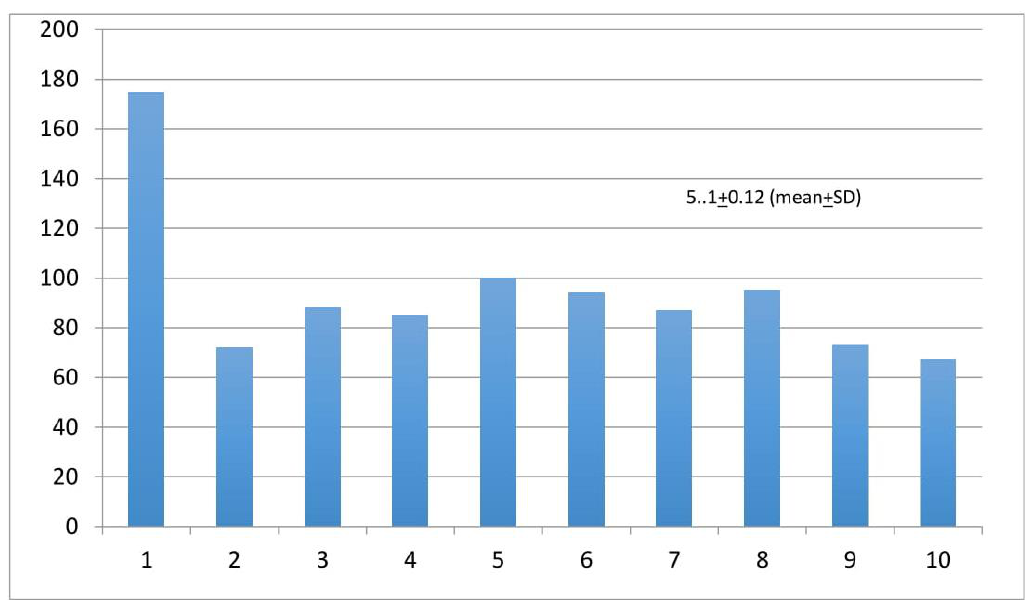
Figure 5. Support from local public health authorities in regards to the protection of physical integrity in the workplace. Likert Scale: 1 = no support, 10 = full support. Y -axis = number of responders.